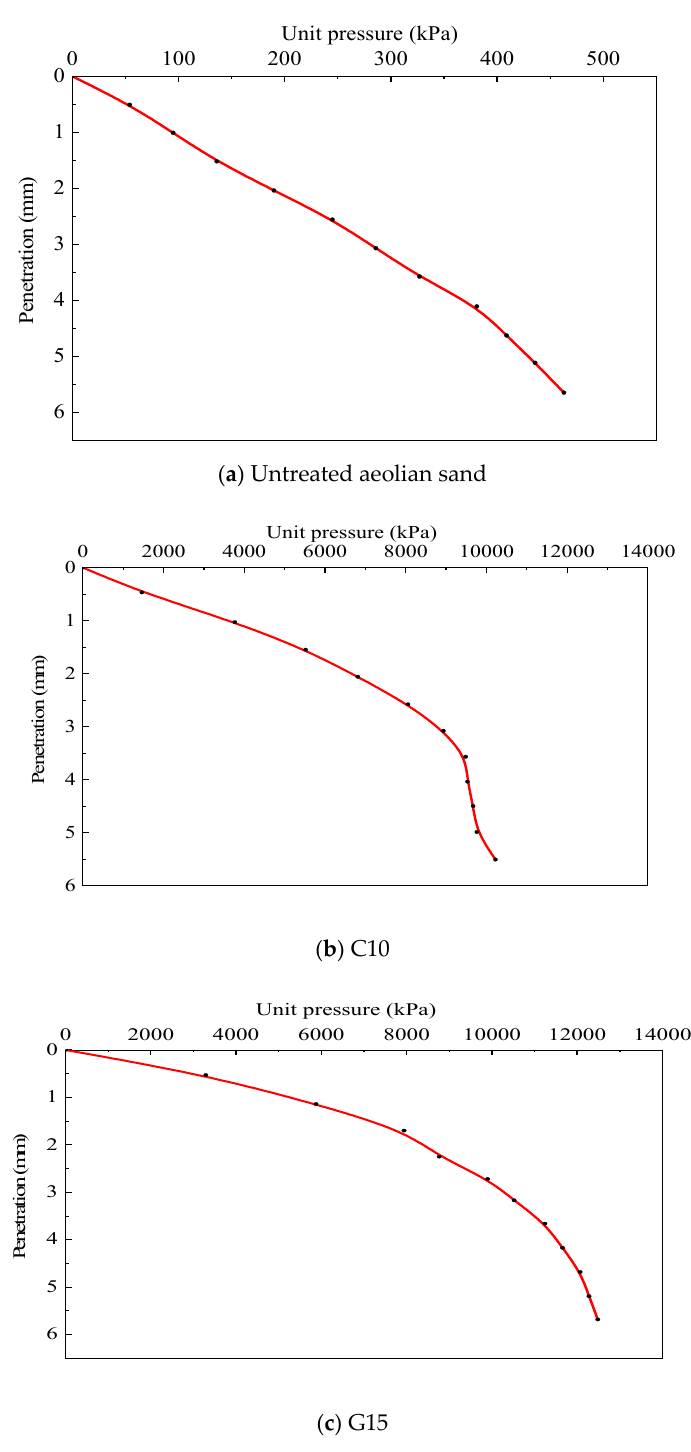
Figure 8. Relationship between unit pressure and penetration.